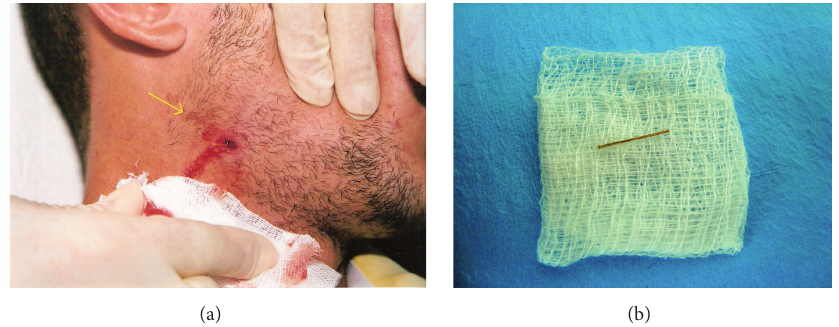
Figure 3: (a) Blade of grass revealed during curettage of cutaneous sinus tract. (b) Blade of grass.